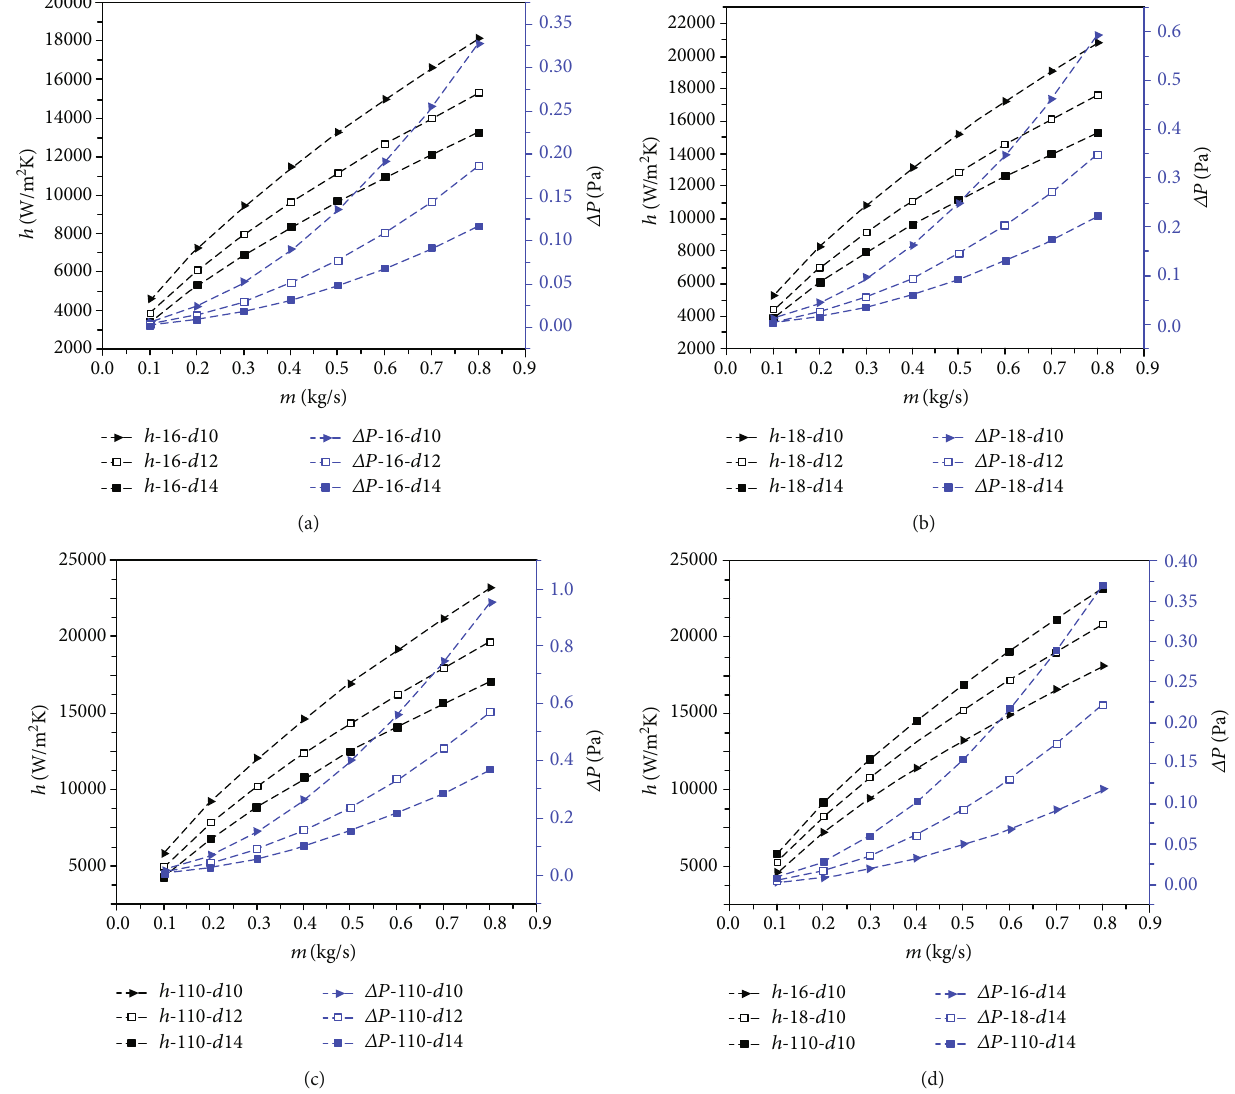
Figure 4: Pressure drop and heat transfer coe ffi cient versus mass fl ow rate: (a) 600 mm length, (b) 1000 mm length, (c) 800 mm length, and (d) maximum heat transfer coe ffi cient and minimum pressure drop among all con fi